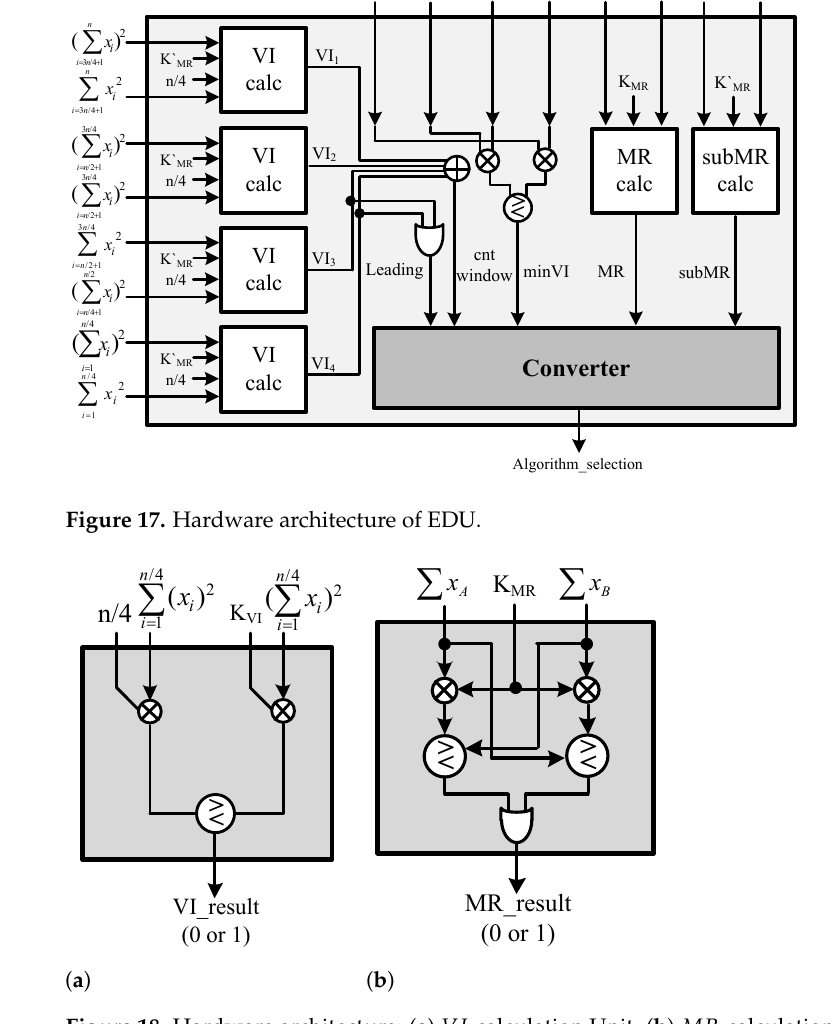
Figure 18. Hardware architecture: ( a ) VI -calculation Unit. ( b ) MR -calculation